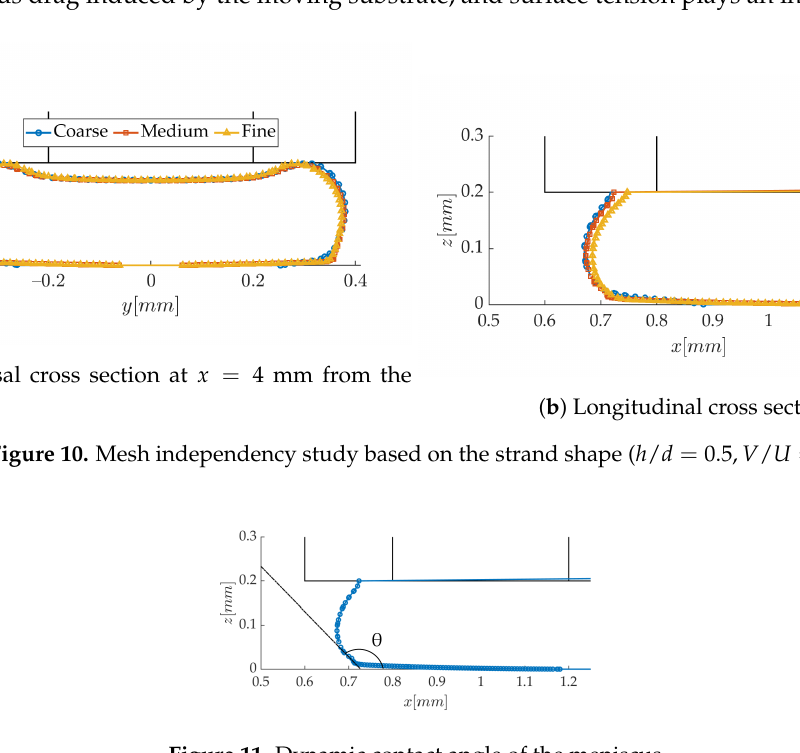
Figure 11. Dynamic contact angle of the